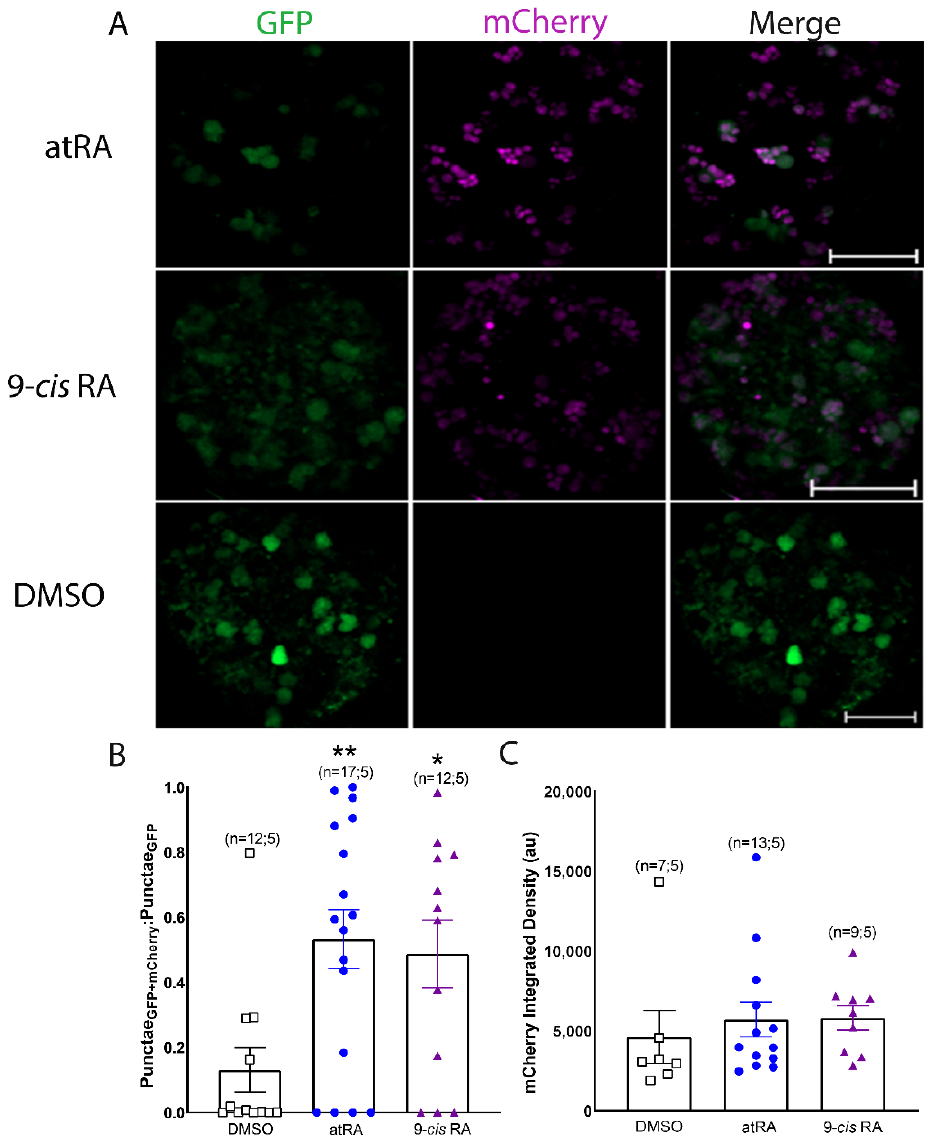
Figure 5. All- trans and 9- cis RA isomers show equivalent activation of the LymRXR sensor. ( A ) Representative images of CNS hemispheres following heat-shock, showing sensor expression (GFP) and transcriptional activity (mCherry) after exposure to either 1 µ M atRA or 1 µ M 9- cis RA, but no transcriptional activity following exposure to 0.01% DMSO, despite sensor expression (GFP only). ( B , C ) Quantitative analysis indicates a significantly higher proportion of GFP punctae containing mCherry following exposure to either 1 µ M atRA or 1 µ M 9- cis RA, compared to DMSO controls ( B ), though there is no significant difference in mCherry integrated density ( C ). * p < 0.05; ** p < 0.01, compared to DMSO. Numbers in brackets represent the total number of CNS and the number of separate trials. Scale bars: 50 μ m.